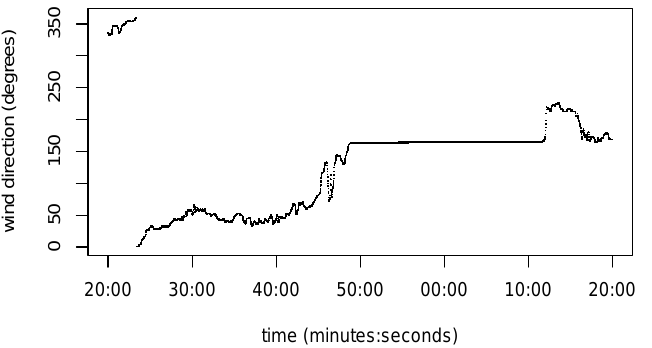
Figure 1. Plot of 3600 wind directions (degrees) with respect to time (minutes:seconds) for the Station 073, Scripps Pier, La Jolla, CA, on 21 January 2021 from 16:20 to 17:19 UTC. Table 3. Starting and ending time of the recorded surface elevations for each of the studied buoys. The time is measured in seconds in UTC.